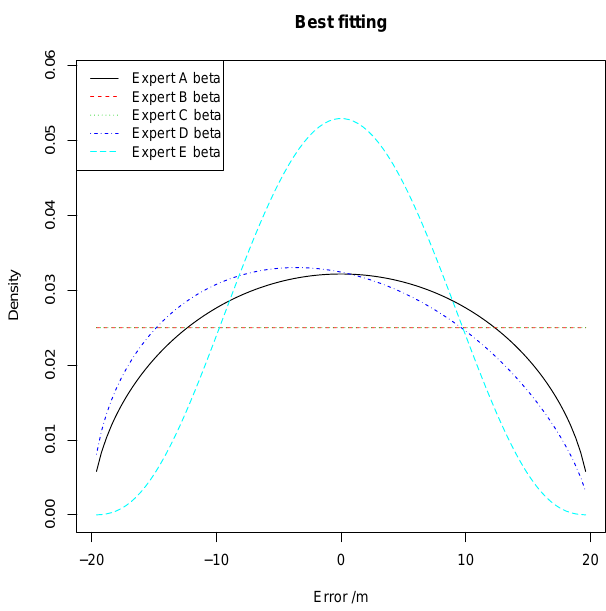
Figure 2. Individual best-fitting distributions for initial expert quar- tiles, scenario 2. Note that the lines for experts B and C